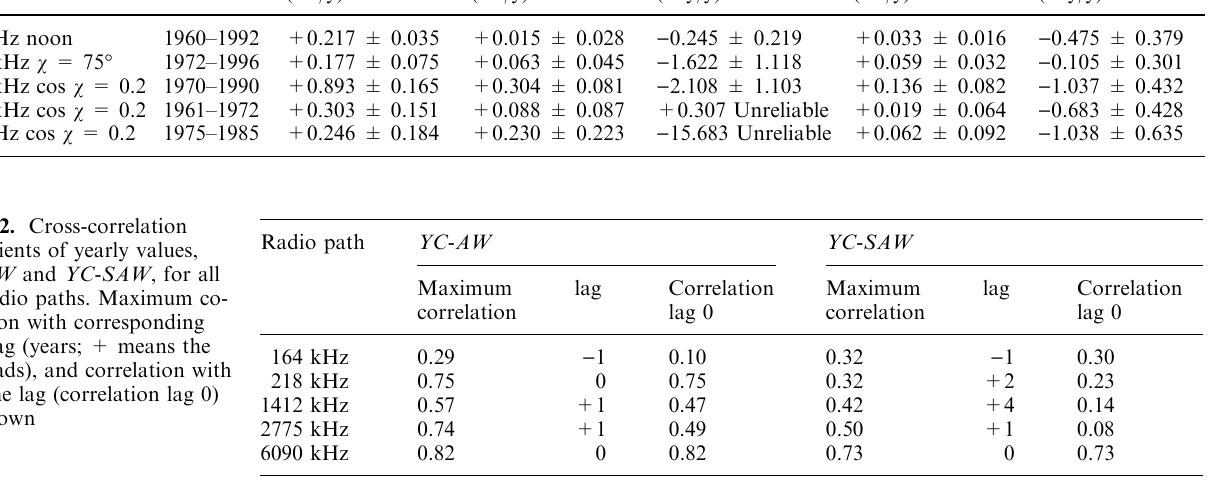
SAW phase (dB/y) (day/y)